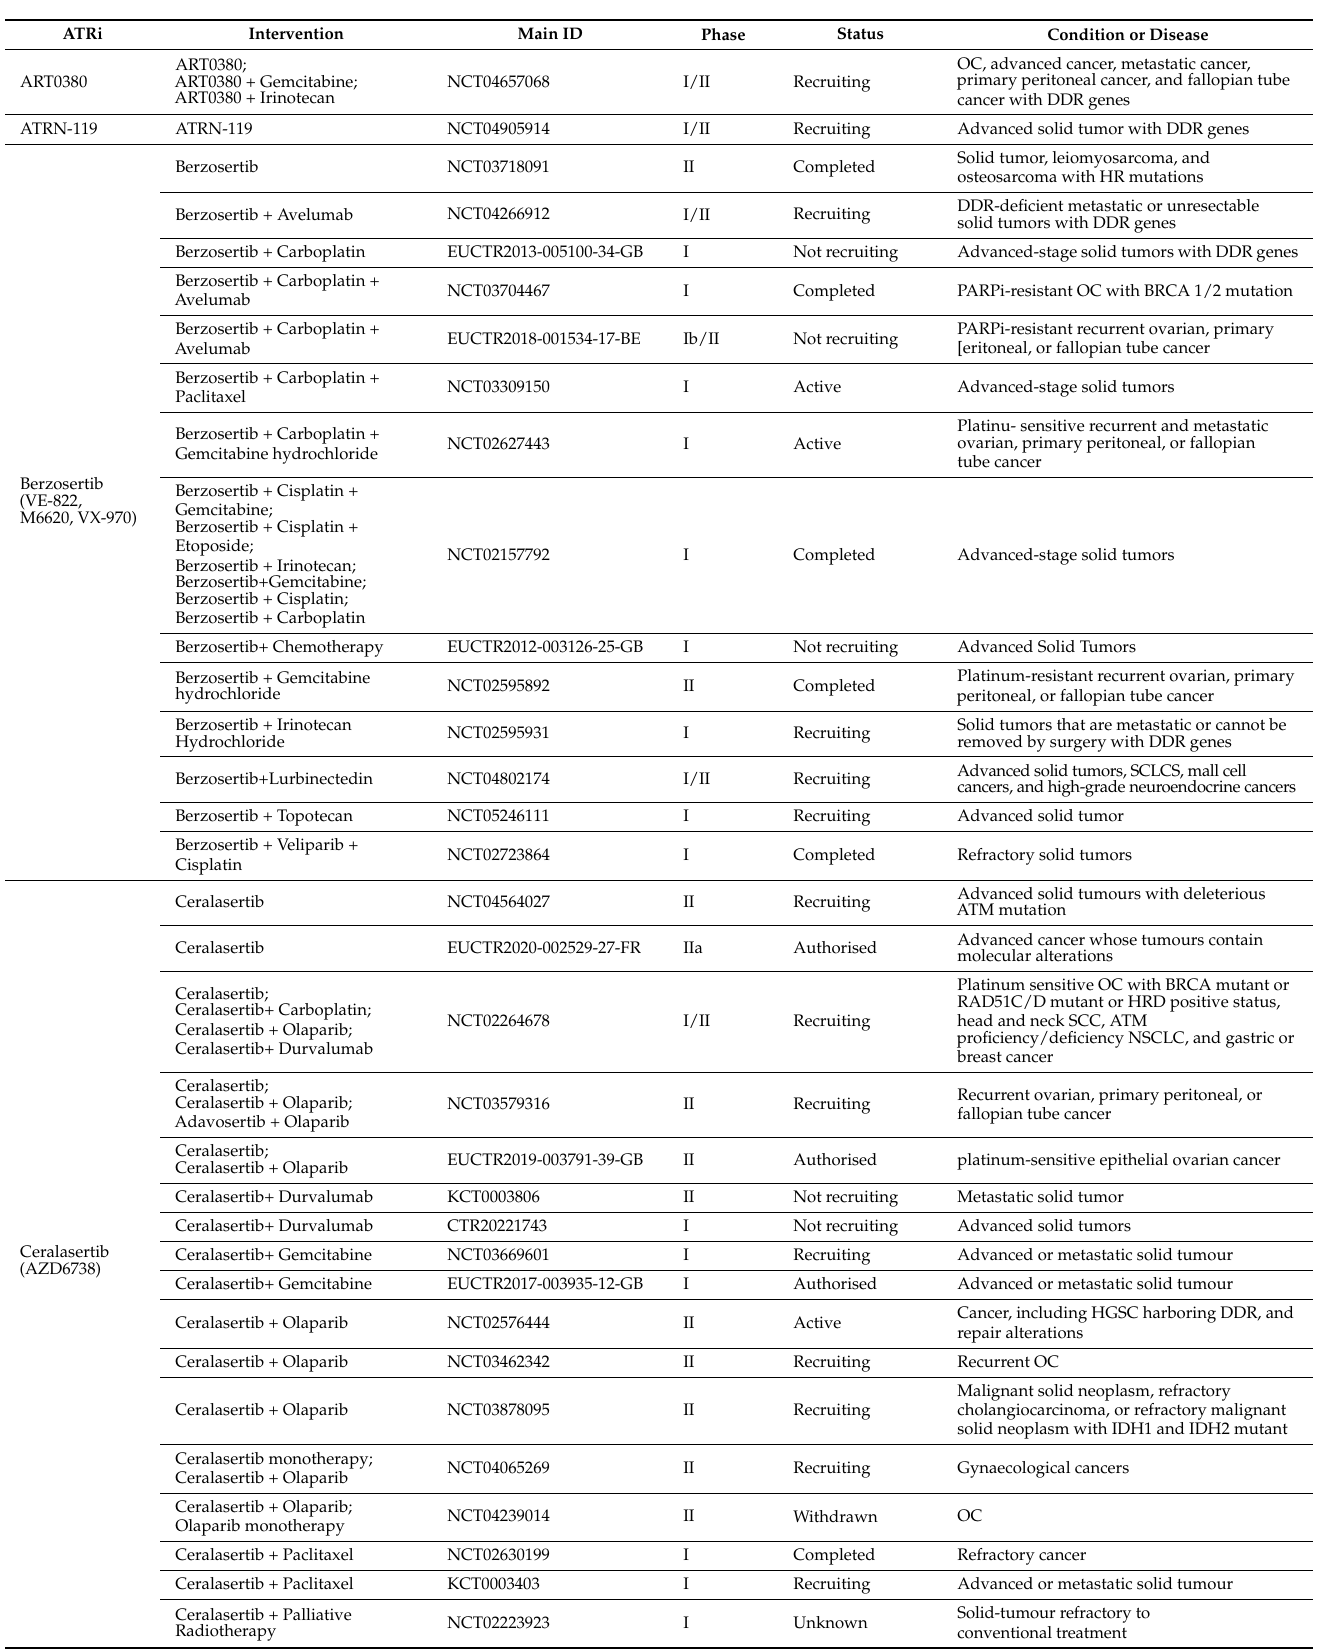
Table 1. Summary of clinical trials related to